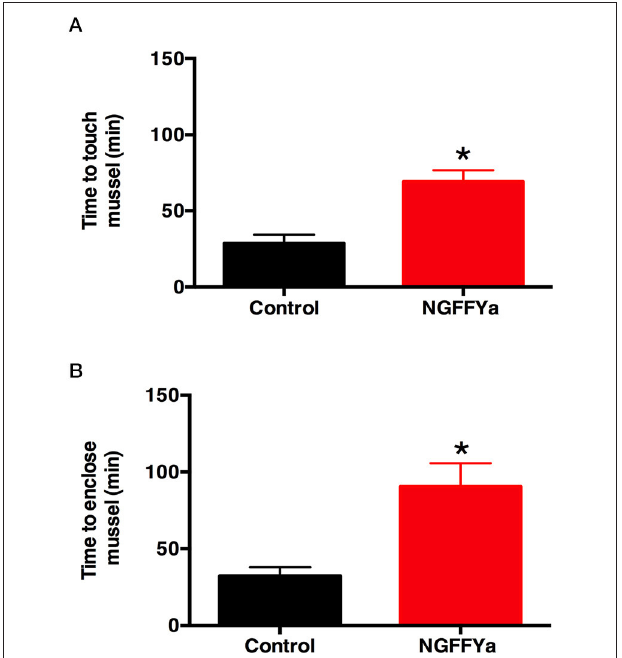
FIGURE 10 | Effects of in vivo injection of NGFFYamide on feeding behavior in A. rubens . (A) Injection of NGFFYamide (10 µ l of 10 − 4 M NGFFYamide; shown in red) causes a significant increase in the time elapsed (minutes) before starfish touch a mussel (see Figure 1A ), by comparison with control or vehicle-injected (10 µ l of distilled water; shown in black) animals. (B) Injection of NGFFYamide (10 µ l of 10 − 4 M NGFFYamide; shown in red) causes a significant increase in the time elapsed (minutes) before starfish enclose a mussel (see Figures 1B,C ), by comparison with control or vehicle-injected (10 µ l of distilled water; shown in black) animals. Data are expressed as mean ± s.e.m ( n = 15 for control group; n = 17 for NGFFYamide-treated group). *Statistically significant differences ( p < 0.005) between vehicle-injected and the NGFFYamide-treated groups, as determined by student t -test (A) or Welch’s t -test (B)